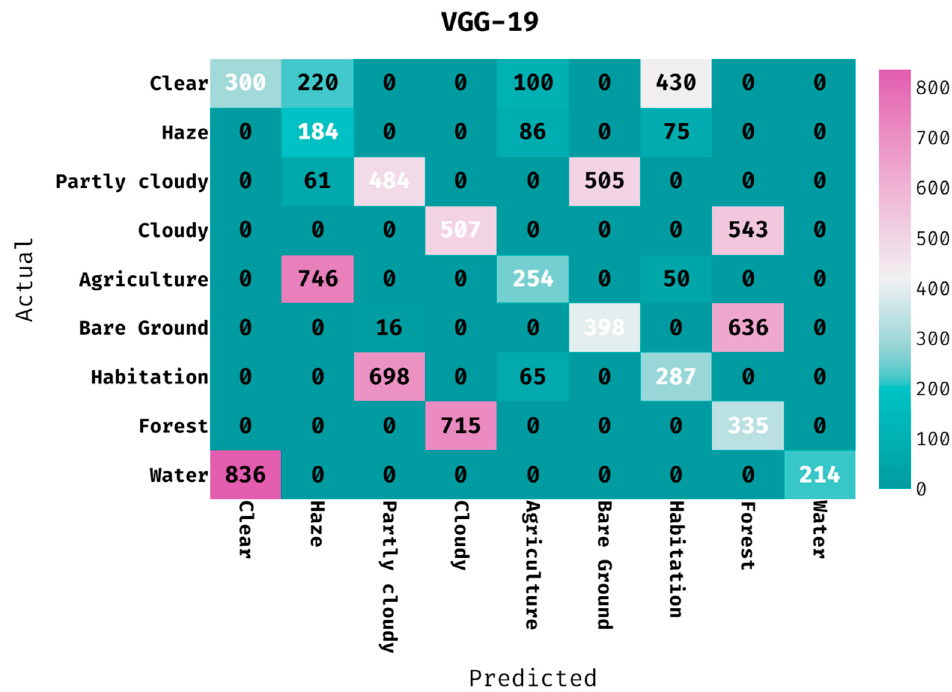
Figure 6. Confusion matrix of VGG-19 model with different classes. Table 1 provides the classification results of the VGG-19 model on the applied dataset.